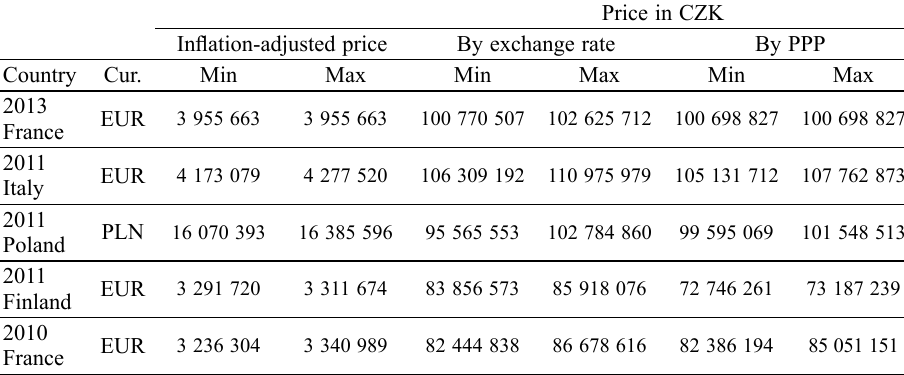
Table 5. Conversion prices to CZK according to exchange rates and PPPs